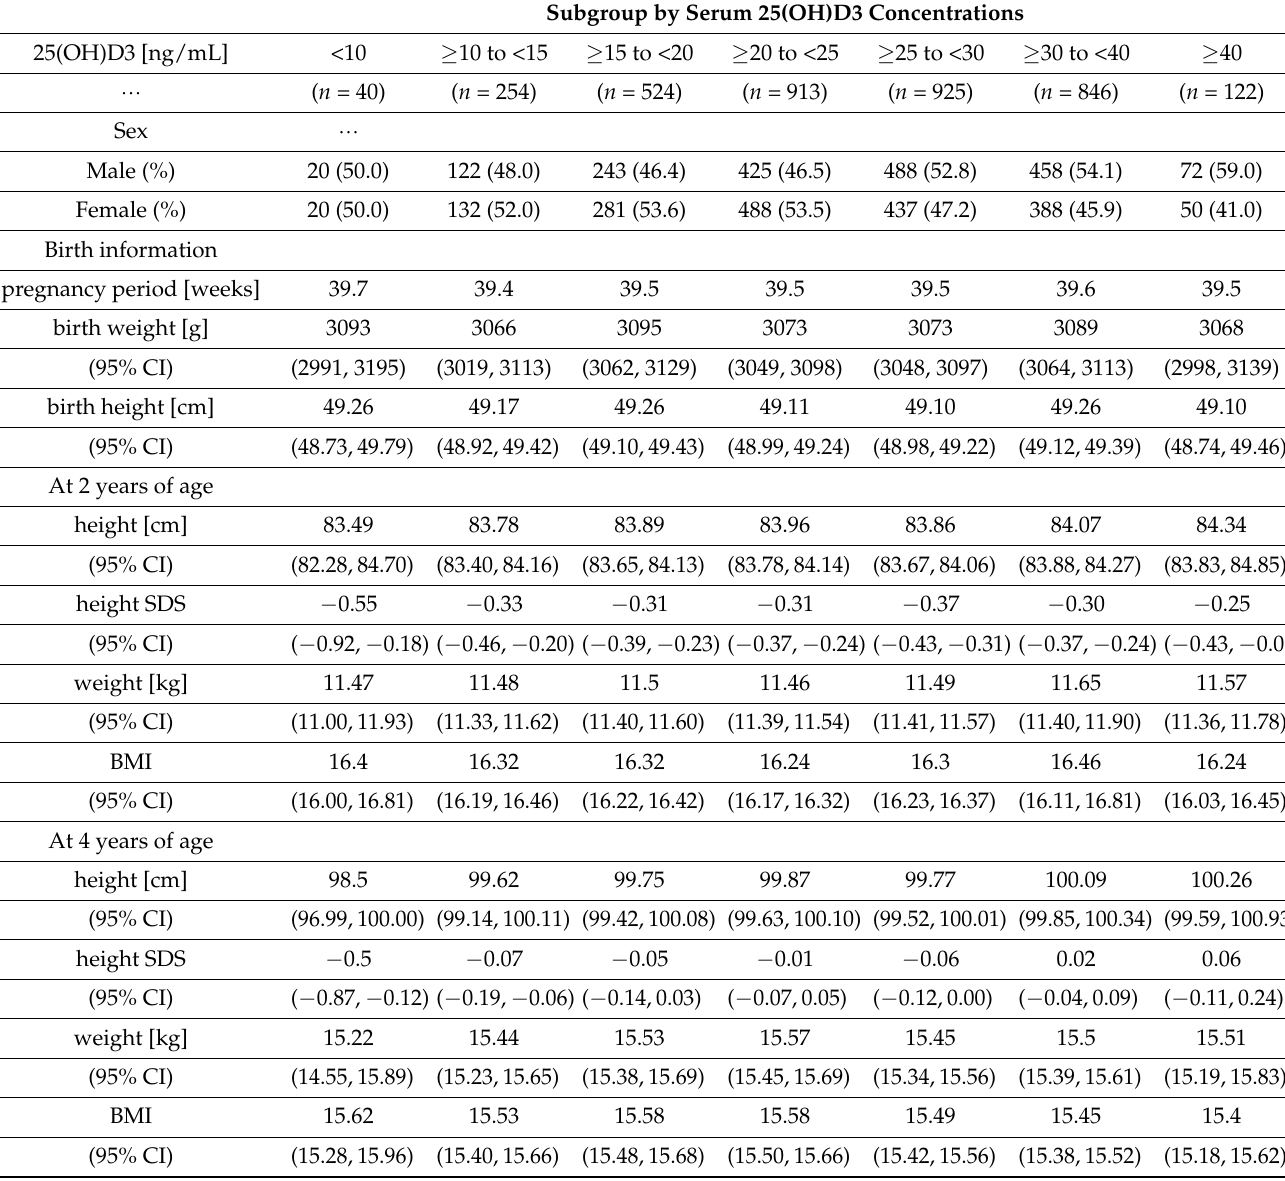
Table 1. Profile of each subgroup by serum 25(OH)D3 concentrations. Subgroup by Serum 25(OH)D3